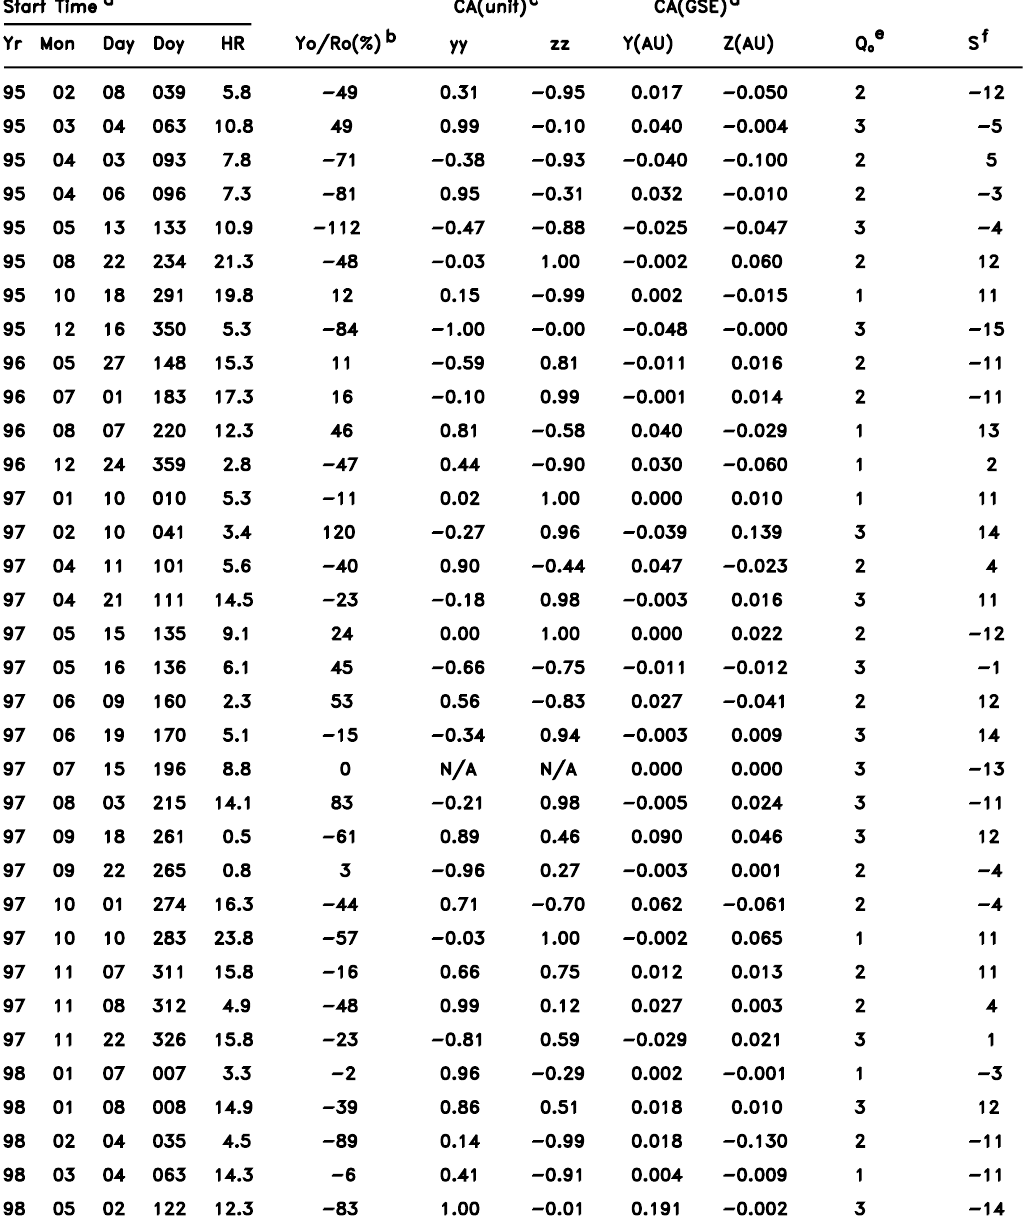
Table 4. Closest approach vectors and magnetic cloud state values. See footnotes at bottom of page